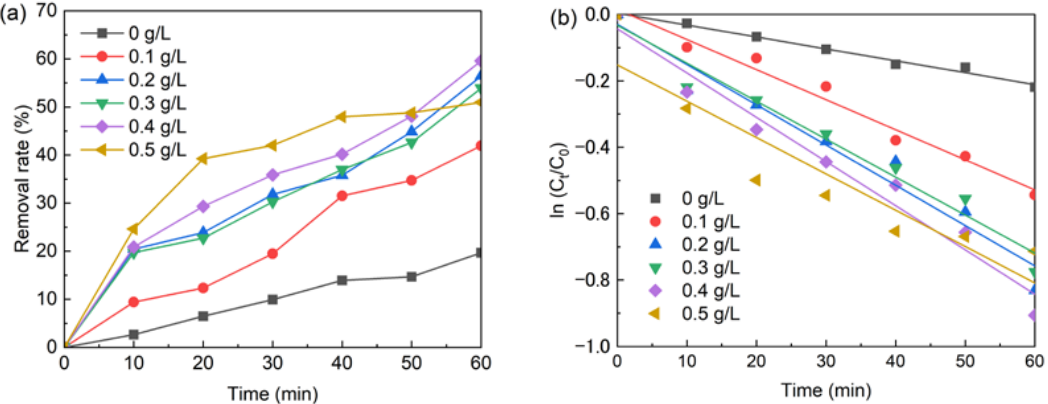
Figure 1. ( a ) The effect of nFe 3 O 4 dosage on BPA removal; ( b ) The kinetic of BPA degradation by nFe 3 O 4 dosage. Conditions: [nFe 3 O 4 ] = 0.1–0.5 g/L, T = 20 ◦ C, pH = 6.8, [PS] = 0.2 mM, [BPA] = 5 mg/L. Table 1. The kinetic parameters of BPA degradation by nFe 3 O 4 dosage.